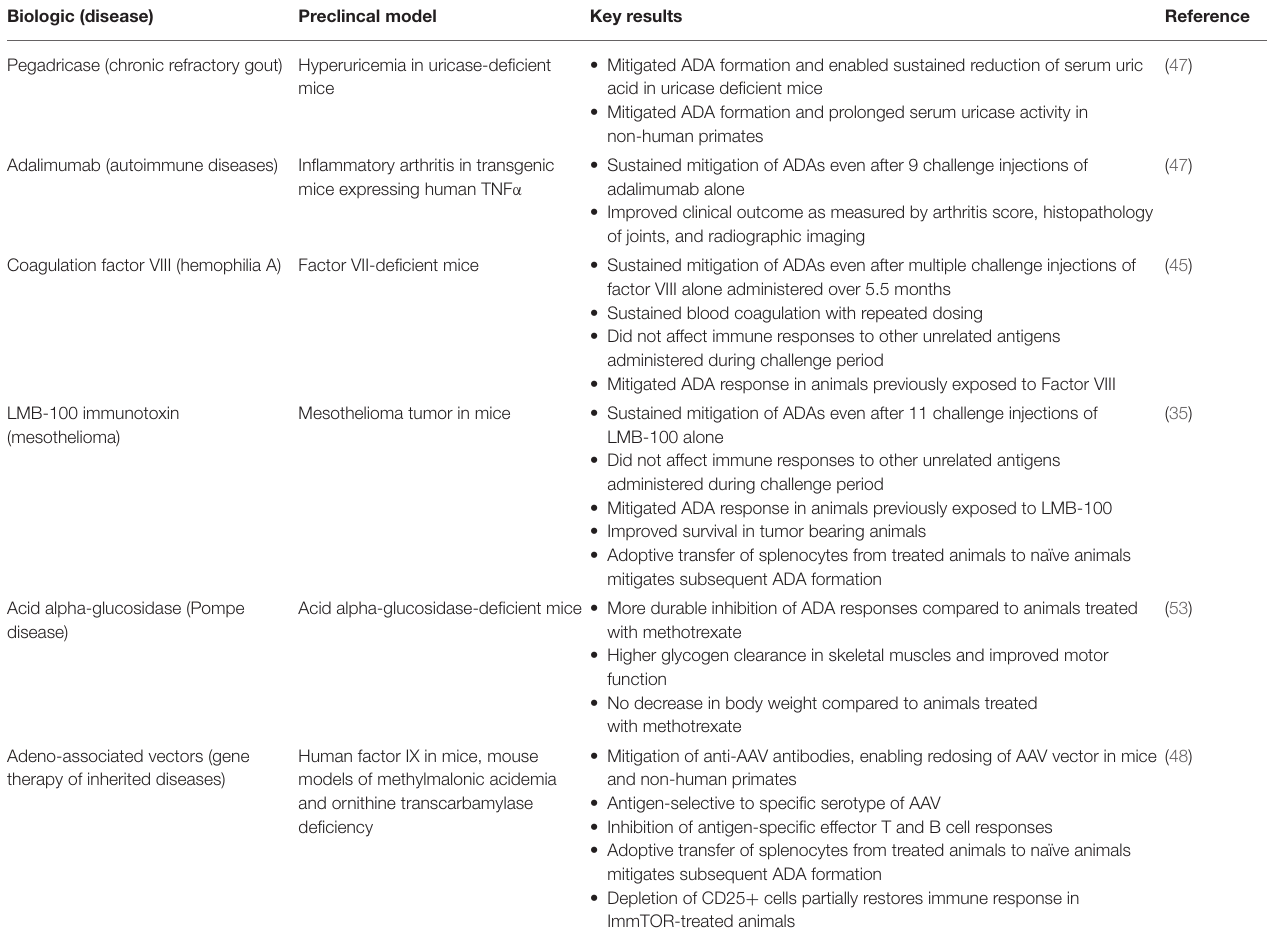
TABLE 1 | Mitigation of antibodies against biologic therapies by ImmTOR in preclinical animal models. Biologic